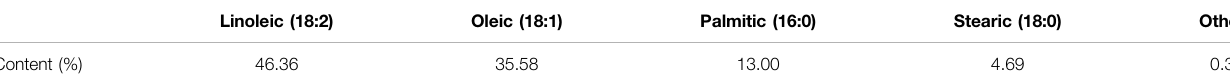
TABLE 1 | Predominant fatty acid composition of WVO. Linoleic (18:2)